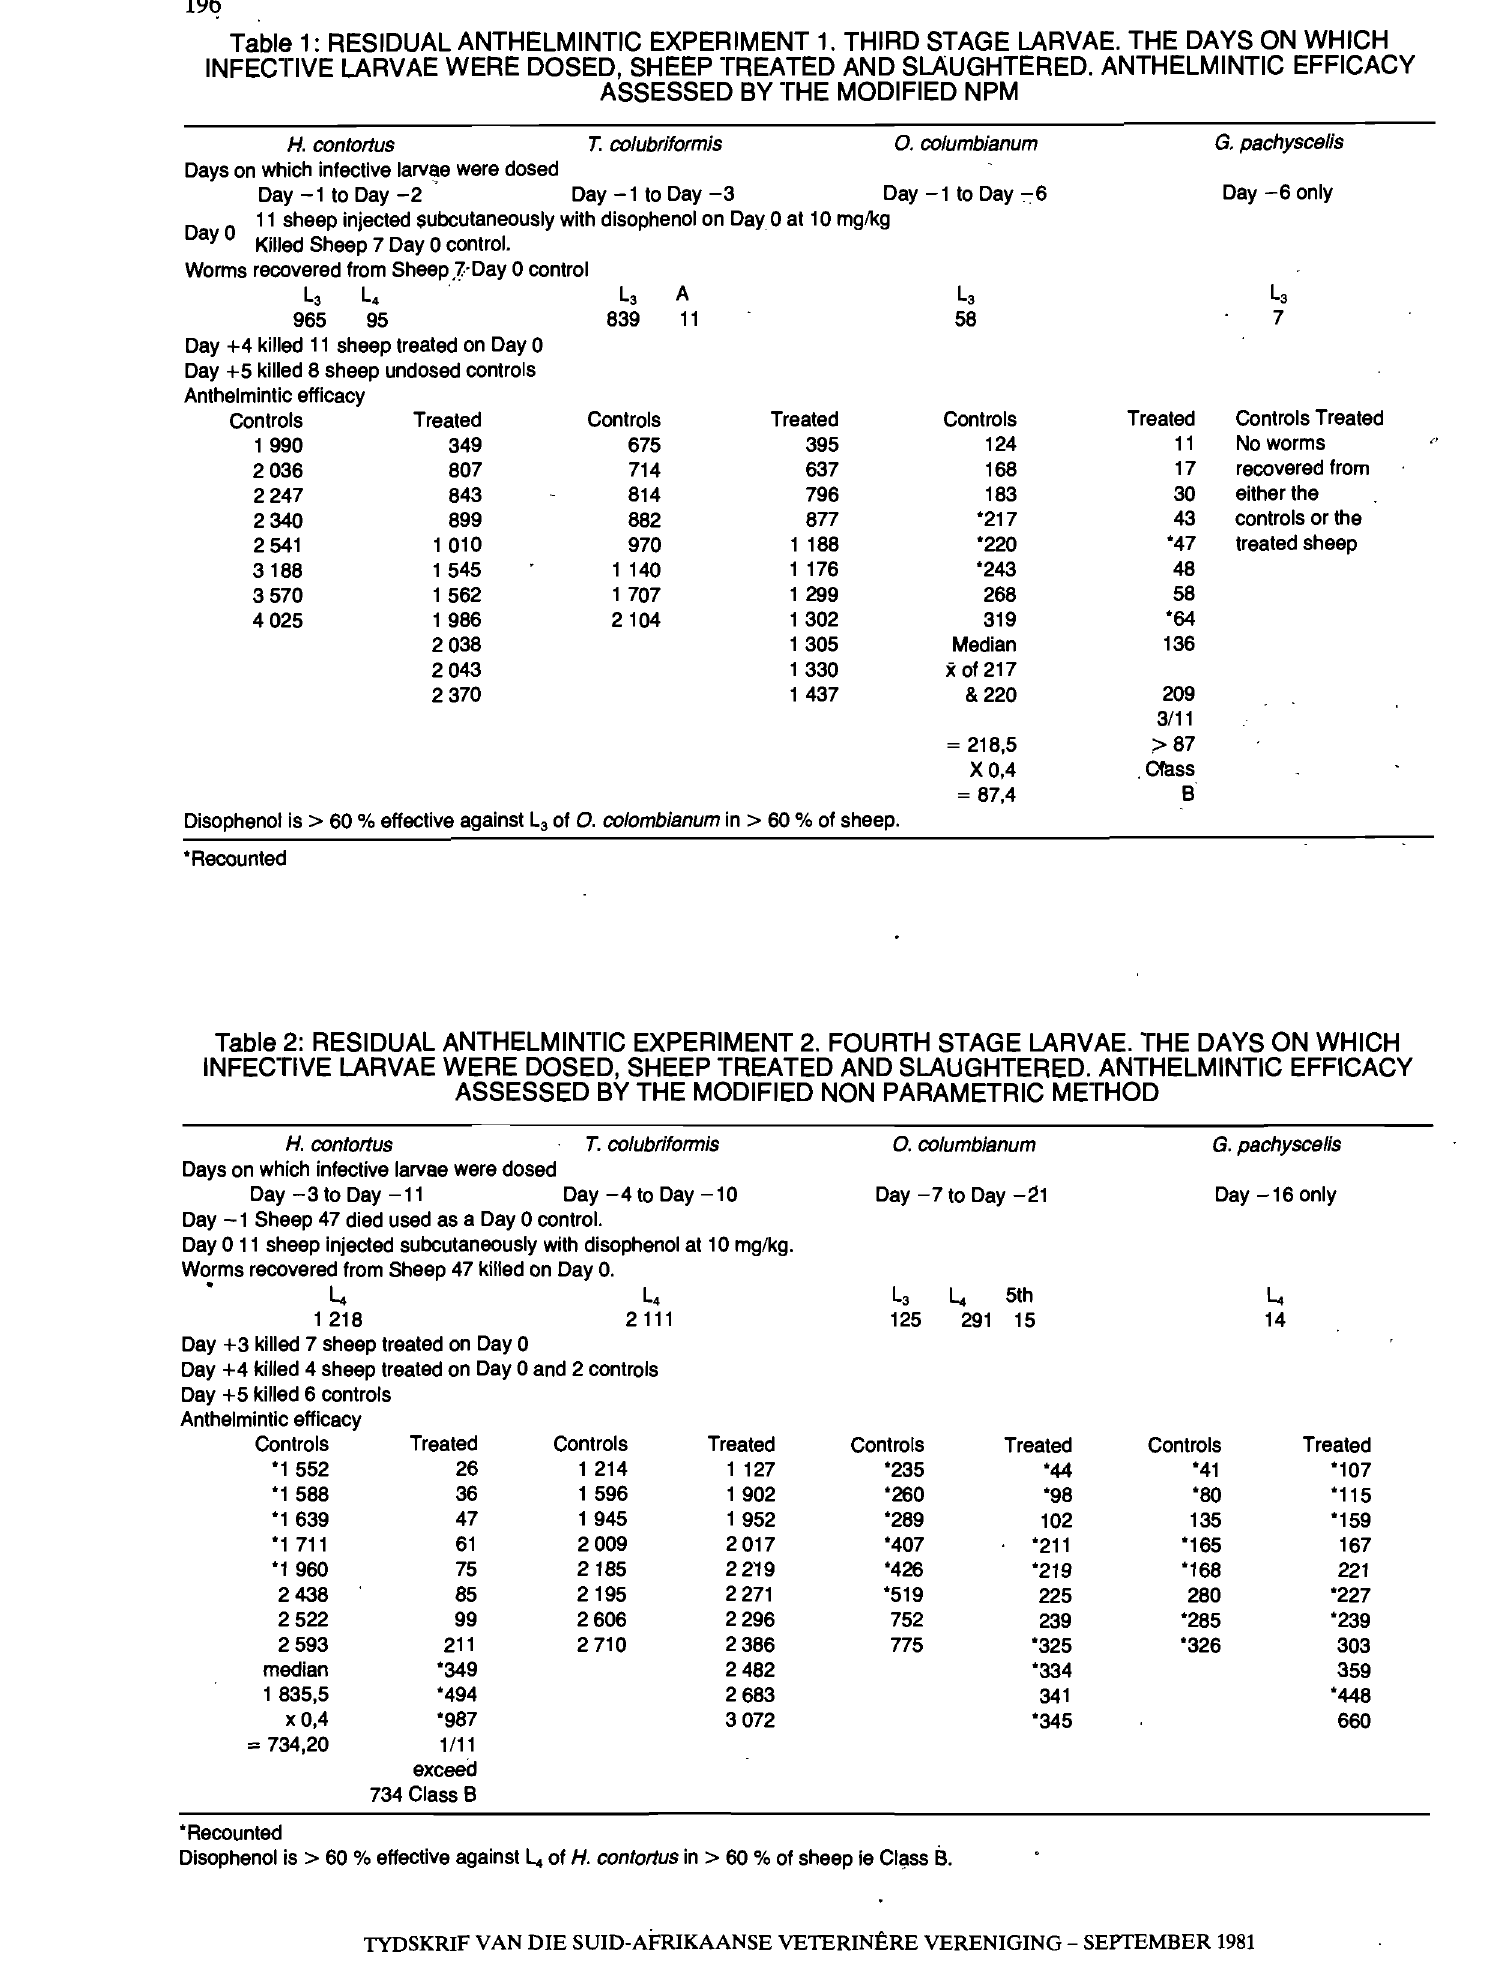
Table 2: RESIDUAL ANTHELMINTIC EXPERIMENT 2. FOURTH STAGE LARVAE. THE DAYS ON WHICH INFECTIVE LARVAE WERE DOSED, SHEEP TREATED AND SLAUGHTERED. ANTHELMINTIC EFFICACY ASSESSED BY THE MODIFIED NON PARAMETRIC METHOD H. con/ortus Day -4 to Day